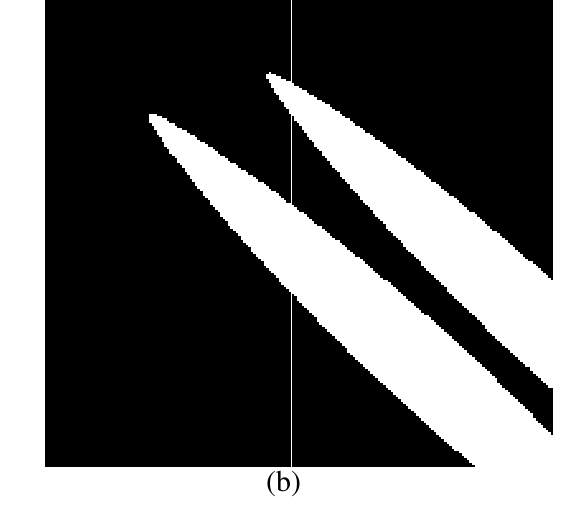
Figure 1. Images that show (a) a wideband picture of the synthetic DIRSIG image and (b) a mask image of the gaussian shaped NH (lower left) and Freon (upper right) 3